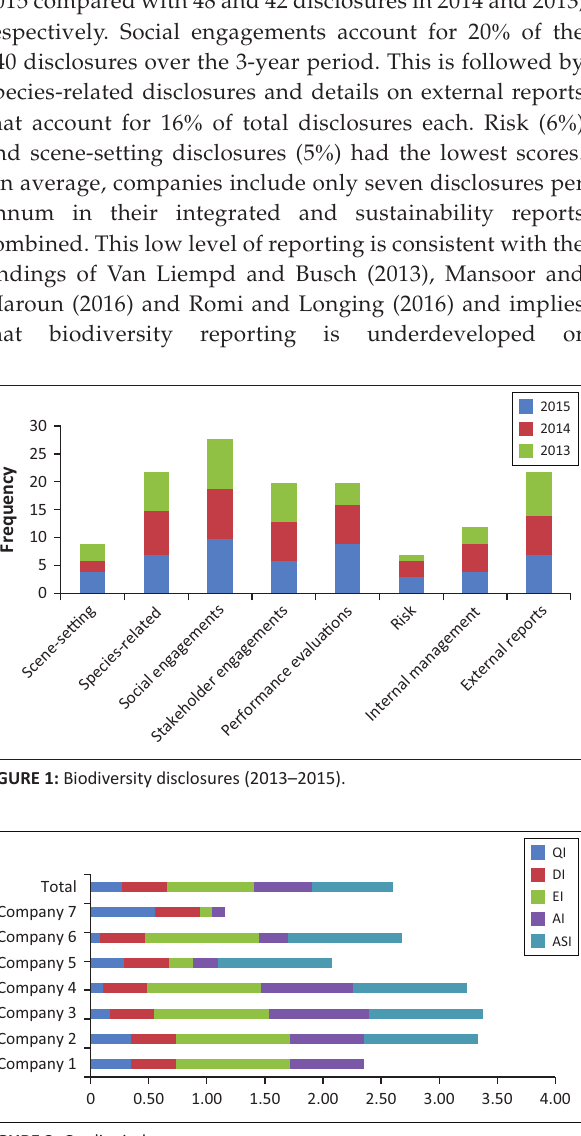
FIGURE 2: Quality